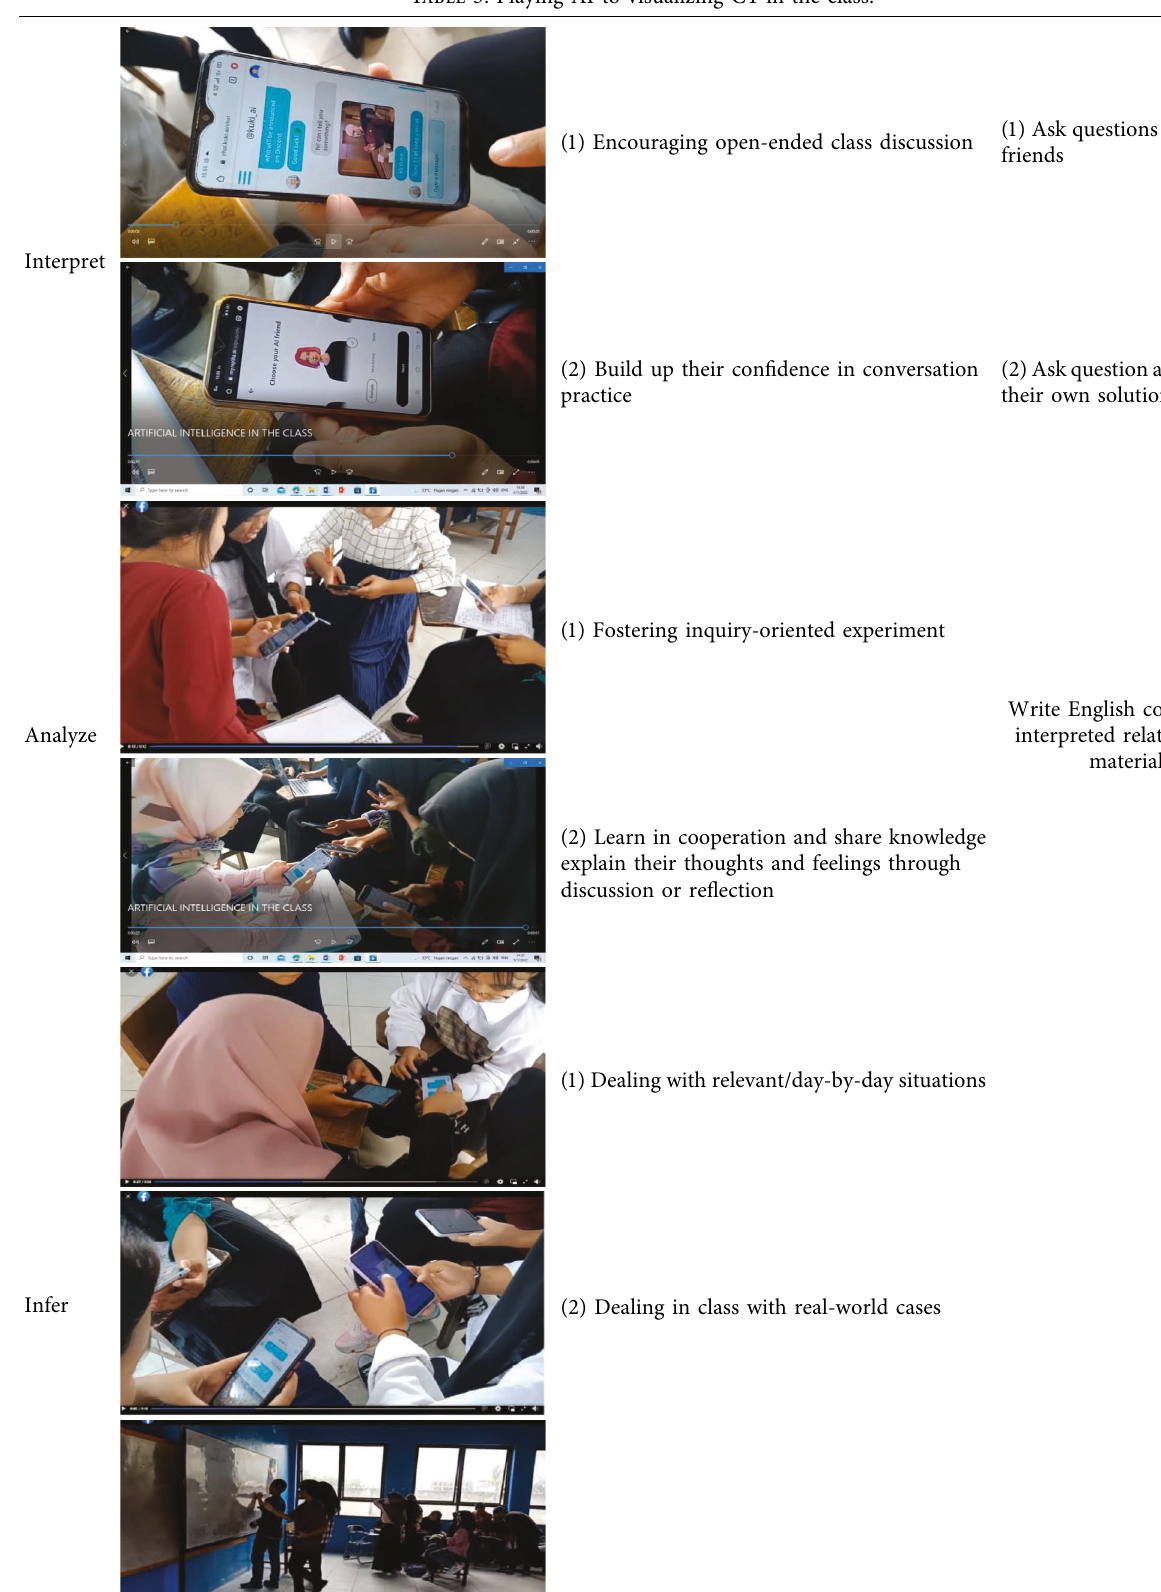
Table 3: Playing AI to visualizing CT in the